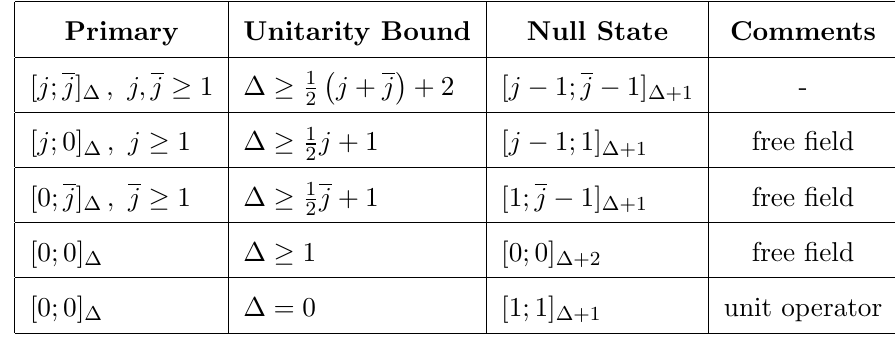
Table 26 . Unitary representations of the conformal algebra in d =